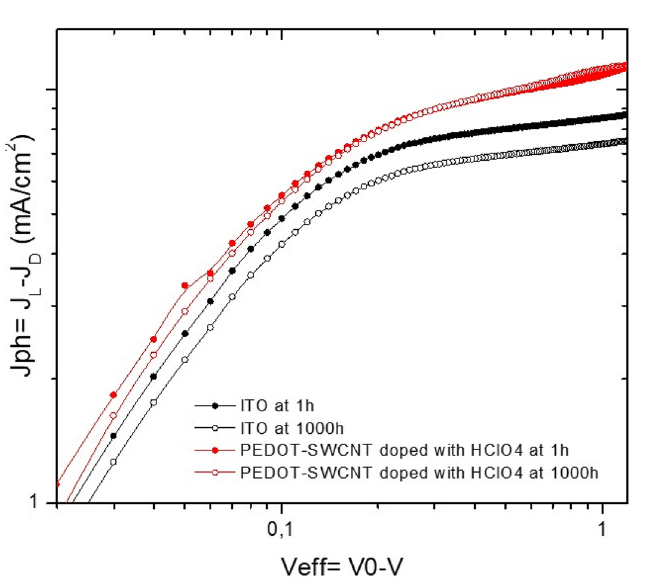
Figure 12. Decay curves under illumination for the Voc, FF, Jsc and PCE (%) for PTB7- PC71BM on ITO/PET (black line) and SWCNTs-PEDOT doped HClO 4 /PET (red line) devices in a glovebox.